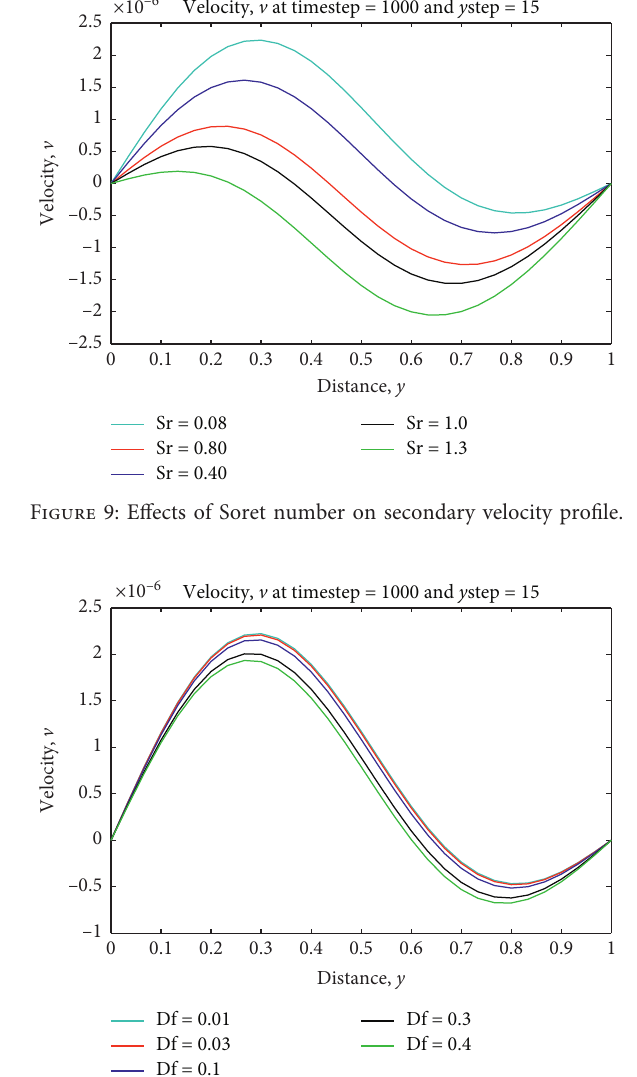
Figure 10: Effects of Dufour number on secondary velocity profile.